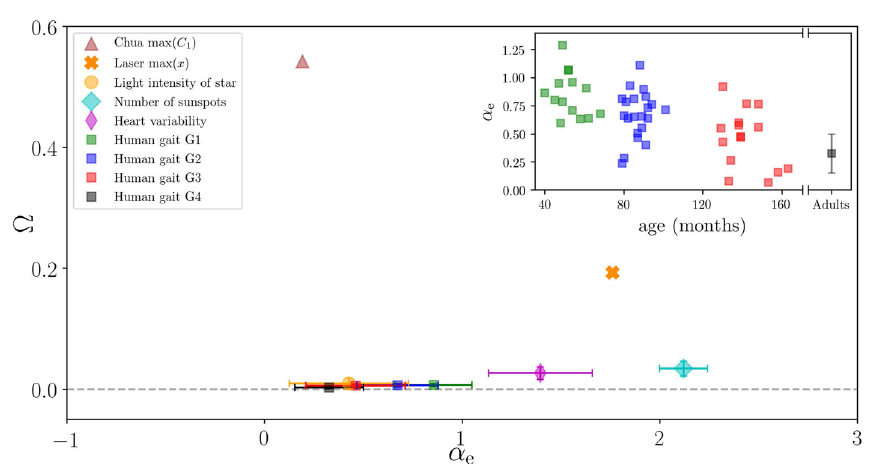
Figure 6. Analysis of empirical time series. Results obtained from each time series are presented in the plane ( α e , (cid:31) ). Deterministic signals are the Chua circuit data (brown triangle) and the laser data (orange ‘X’ marker) that have � > 0.0 . The other signals [the light intensity of a star (yellow dot), the number of sunspots (cyan diamond), the heart variability of healthy subjects (magenta thin diamond), and the different groups of human gait dynamics (green, blue, red, and black squares)] are stochastic and have (cid:31) ≈ 0 . For the human gait, the inset depicts the α e as a function of the age of each subject. Consistent with 40 , the correlation coefficient α e decrease with the